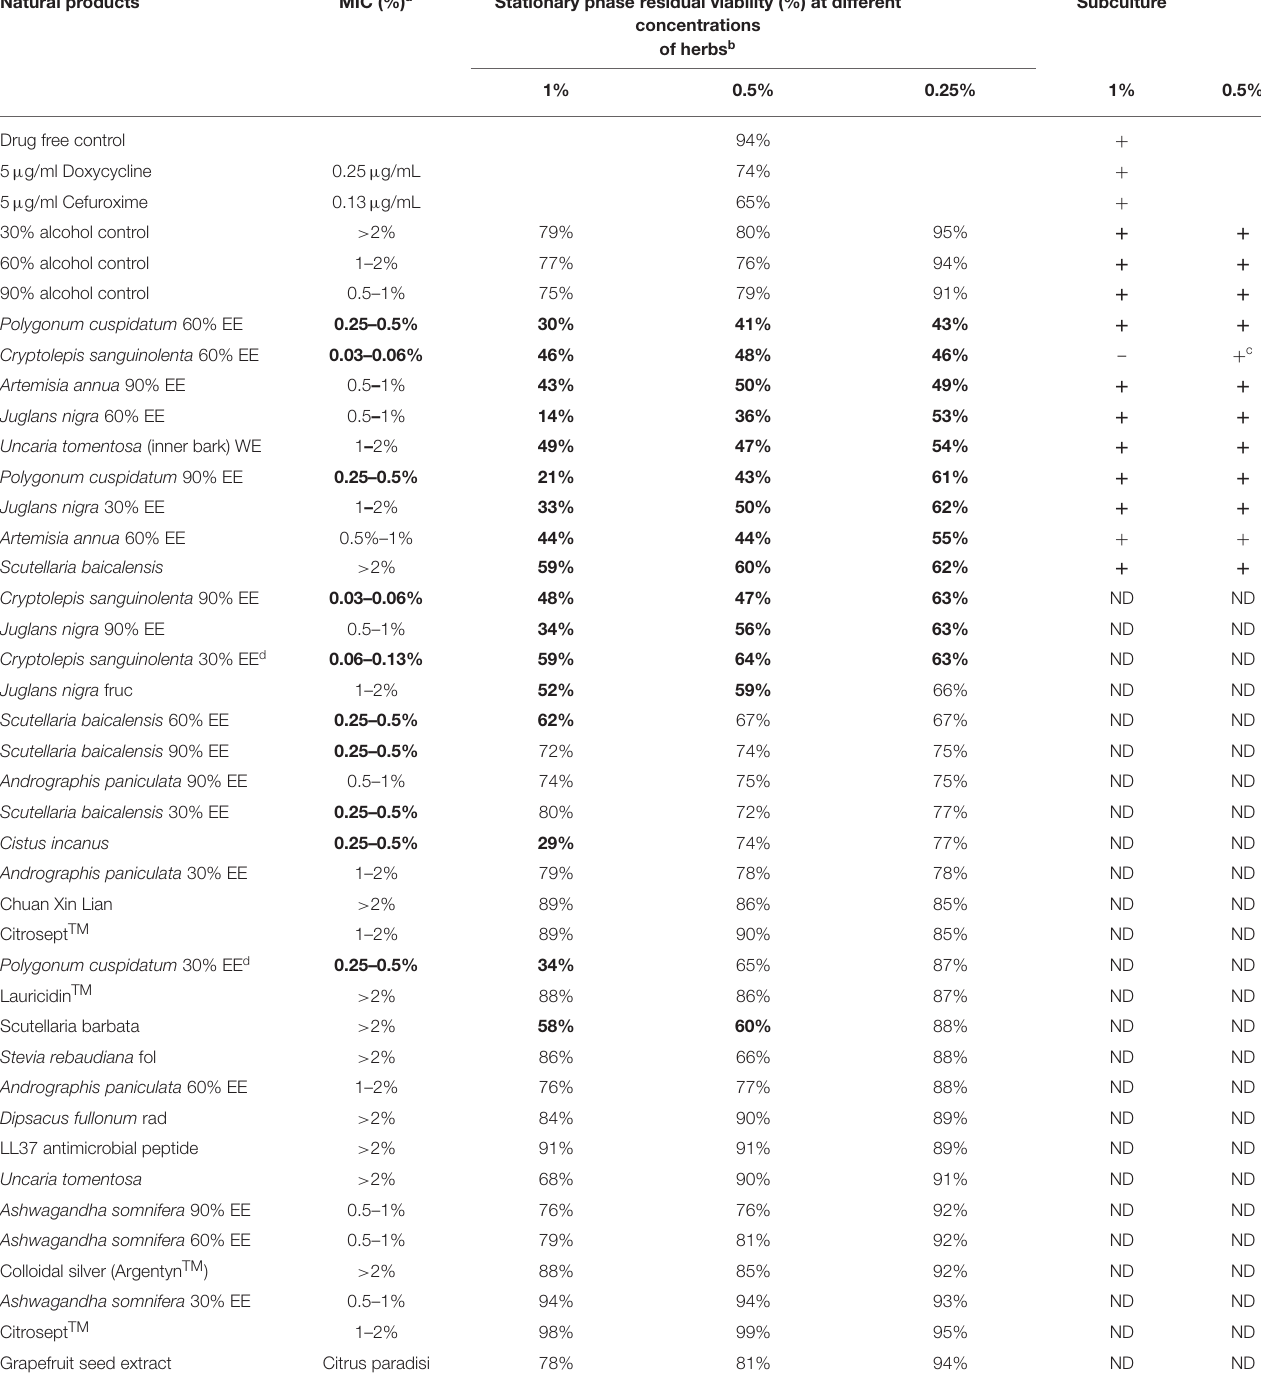
TABLE 2 | Activity of natural products against growing (MIC) and stationary phase B. burgdorferi . Natural